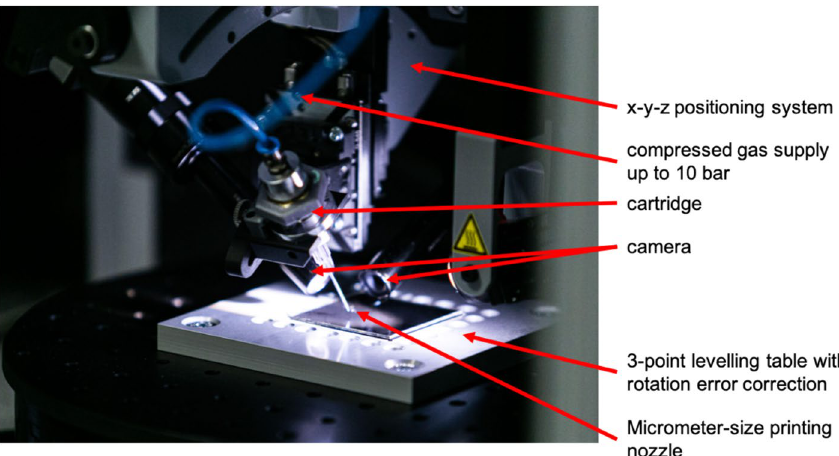
Figure 3. Photo of the printing system implementing the UPD technology. The sample is placed on a 3-point levelling table with rotation error correction. The printhead is positioned using 3-axes positioning system and vision